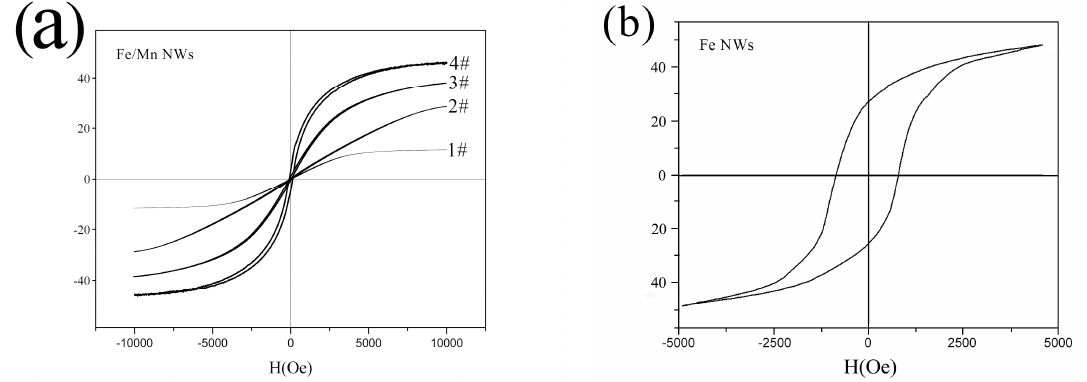
Figure 6. Typical hysteresis loops of NWs at 300K: ( a ) Fe/Mn@SiO 2 multilayer NWs; ( b ) Fe@SiO 2 NWs. Table 4. Magnetic properties of NWs.